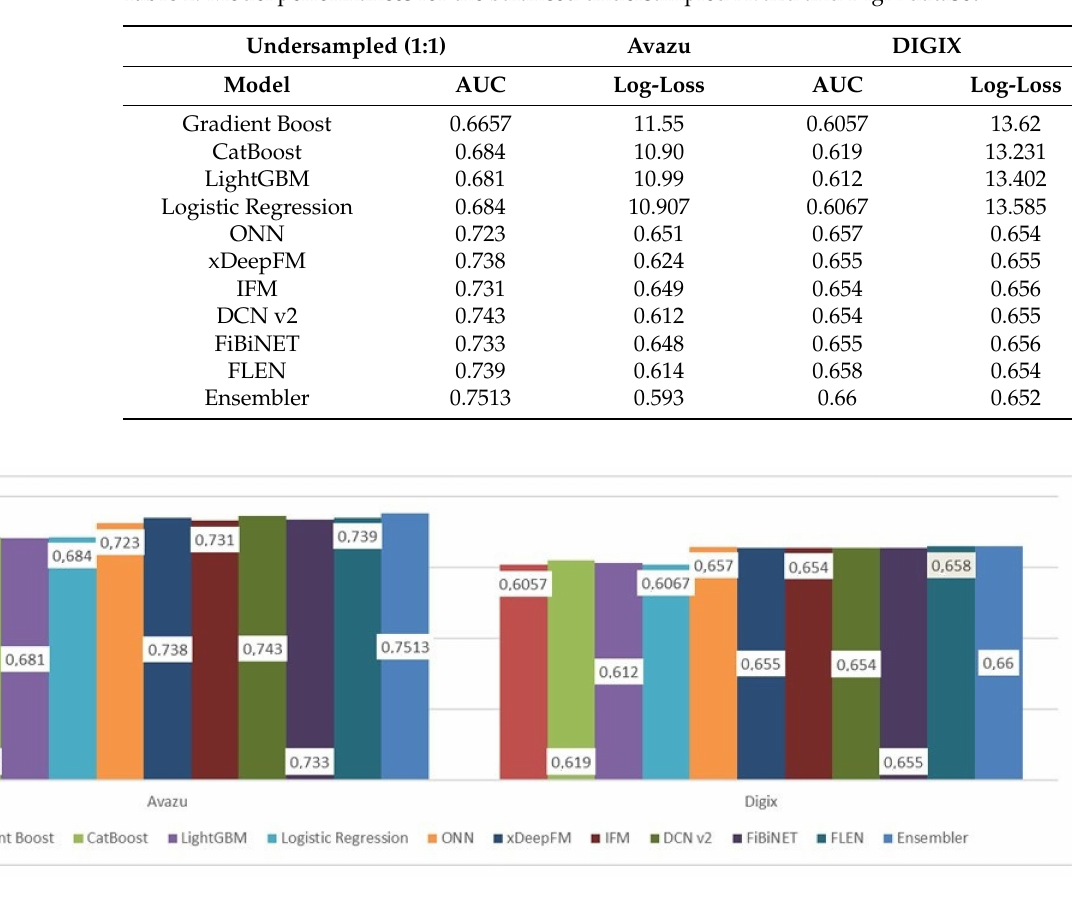
Figure 3. AUC scores for the balanced undersampled Avazu and Digix